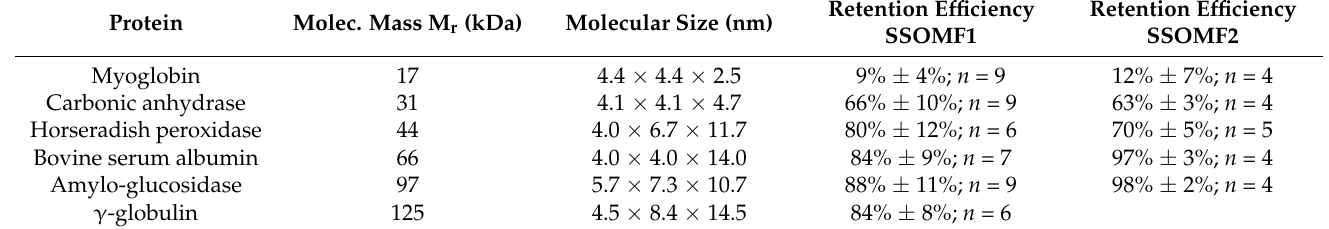
Table 1. Molecular mass (M r ), molecular size, and retention efficiency of Saccharolobus solfataricus P2 fragments deposited on microfilter 1 (SSOMF1) and 2 (SSOMF2), respectively, for selected proteins. Protein Molec. Mass M r (kDa)